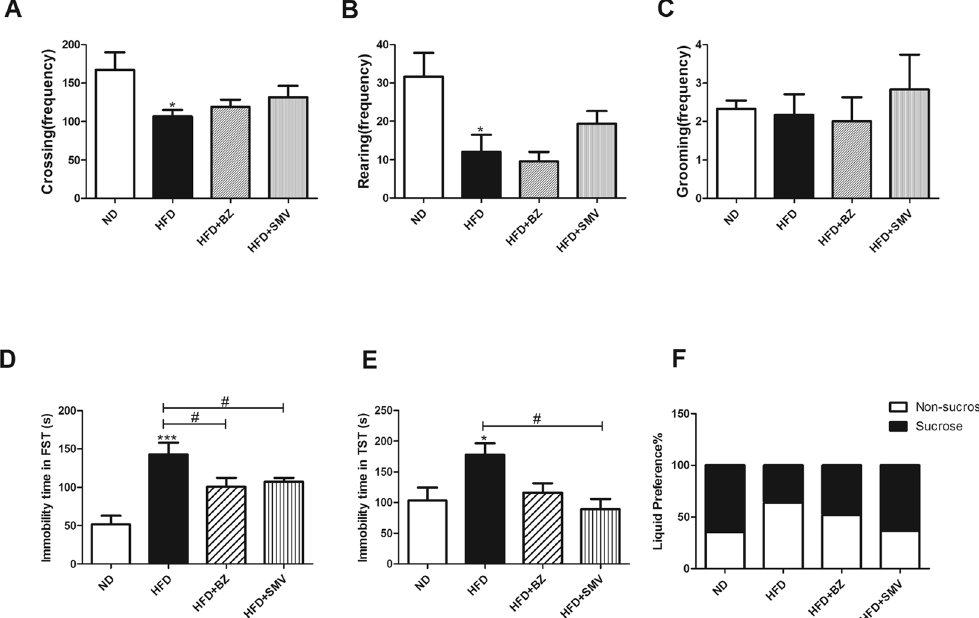
Figure 2. The effects of high fat diet and drug intervention (BZ&SMV) on the emotionality parameter mice. Number of crossings ( A ), rearings ( B ) and groomings ( C ) in the OFT. Immobility time (s) in the FST ( D ) and TST ( E ). The liquid preference (percentage) in the SPT ( F ). * P < 0.05; ** P < 0.01; *** P < 0.001 vs. ND group. # P < 0.05 vs. HFD